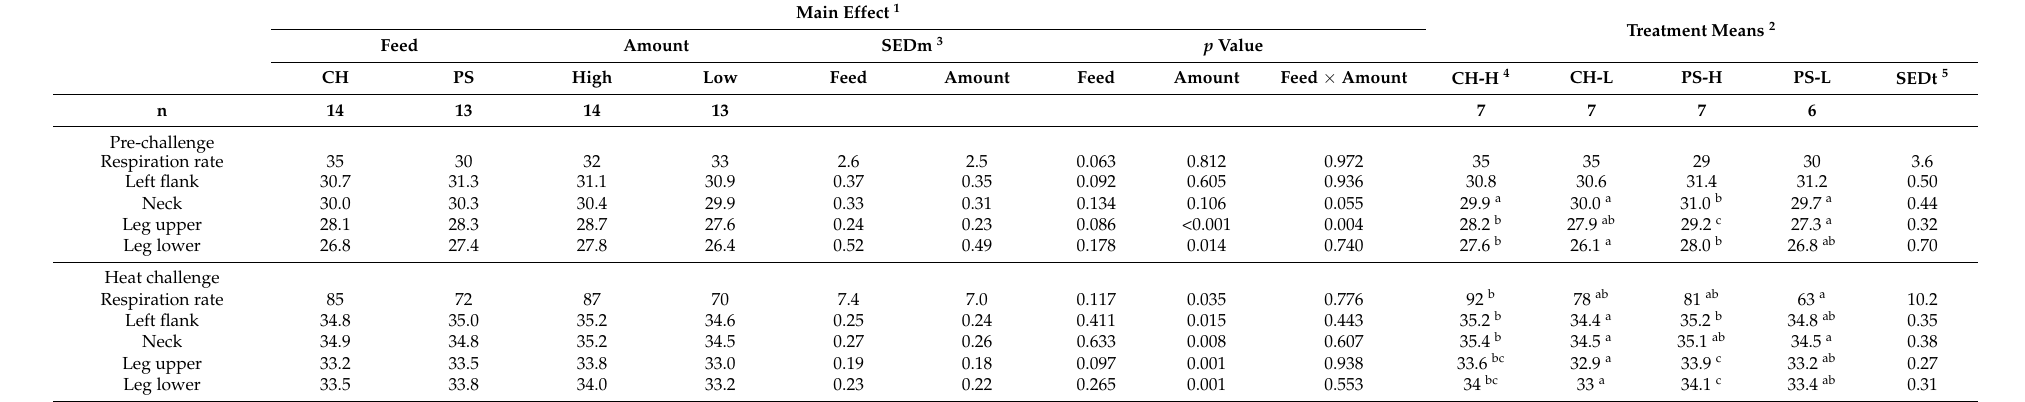
Table 8. Respiration rate (breaths per min) and skin temperatures ( ◦ C) at 14:45 h during selected periods of the